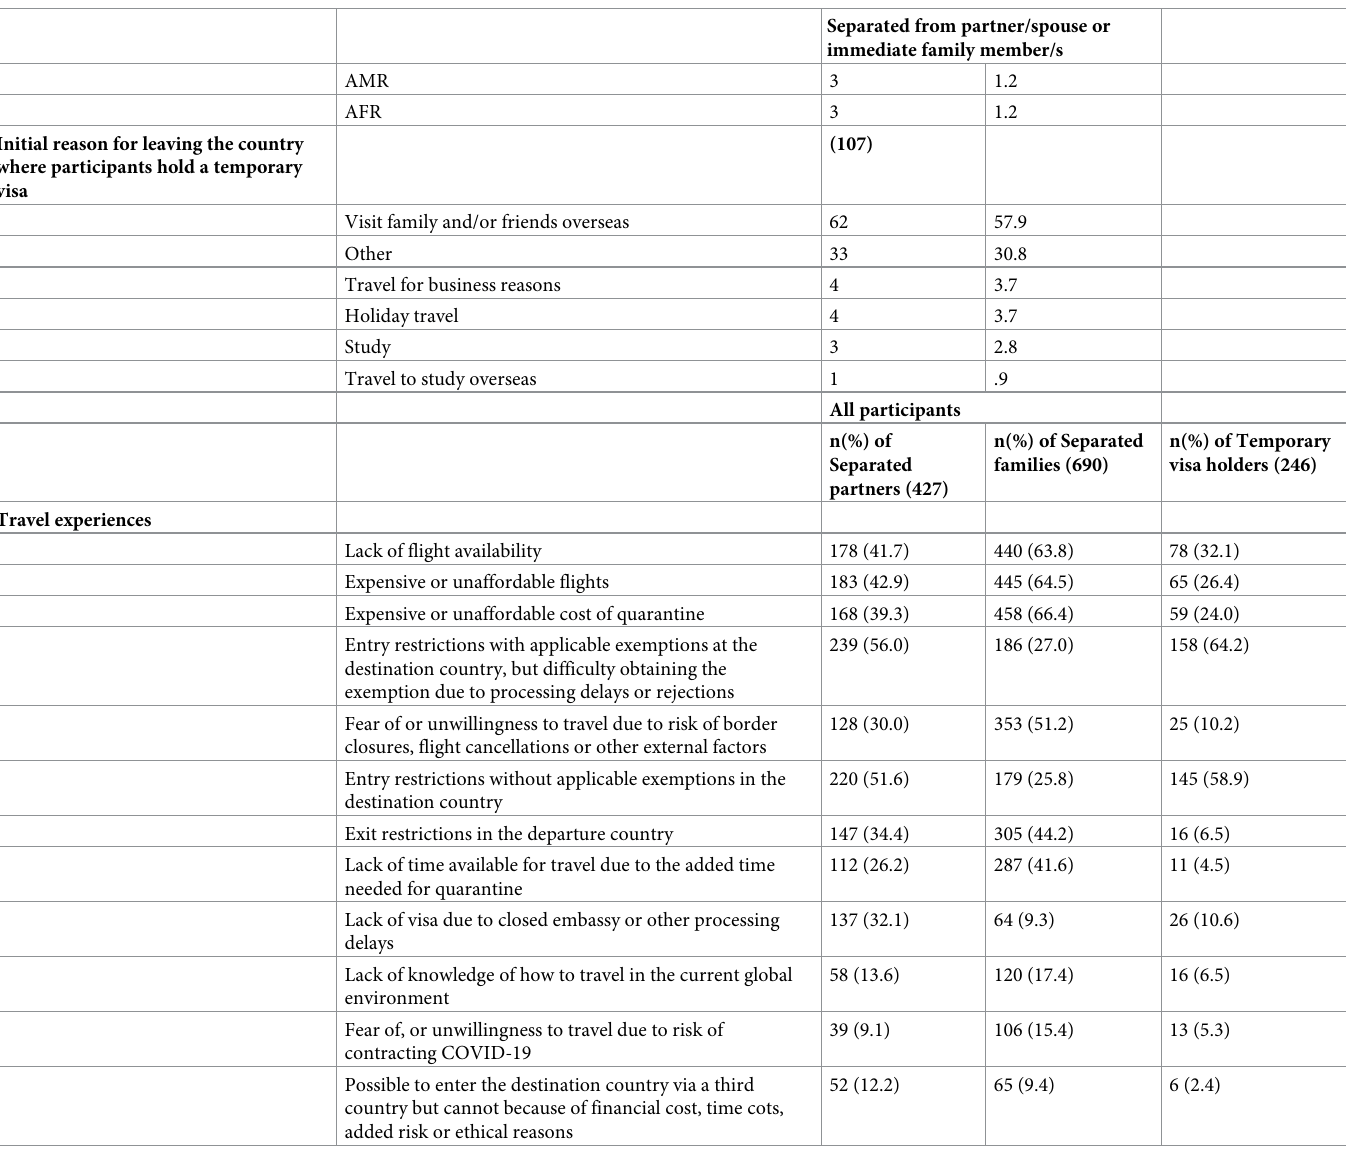
Mental wellbeing Mean values and standard deviations for each of the DASS-21 subscales were 11.6 ± 5.9 for depression, 6.8 ± 5.5 for anxiety and 11.5 ± 5.6 for stress. Converted, this translates to 76.8% (1046/1363) meeting the DASS-21 criteria for moderate-to-extremely severe depression, 51.6% (703/1363) between moderate-to-extremely severe anxiety, and 62.6% (853/1363) between moderate-to-extremely severe stress. Fig 2 shows the distribution of DASS-21 mean scores by respondents’ situation. The overwhelming majority of respondents reported a lack